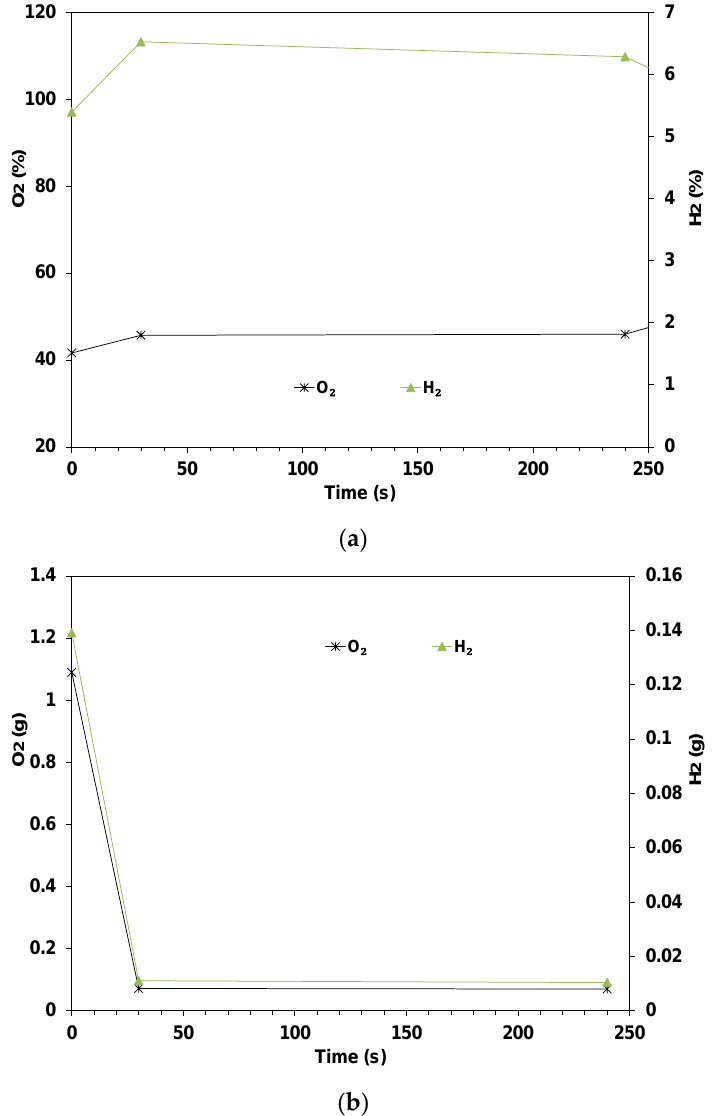
Figure 13. O 2 and H 2 concentration of dry pellets at 264 °C: ( a ) in percentages and ( b ) in grams.